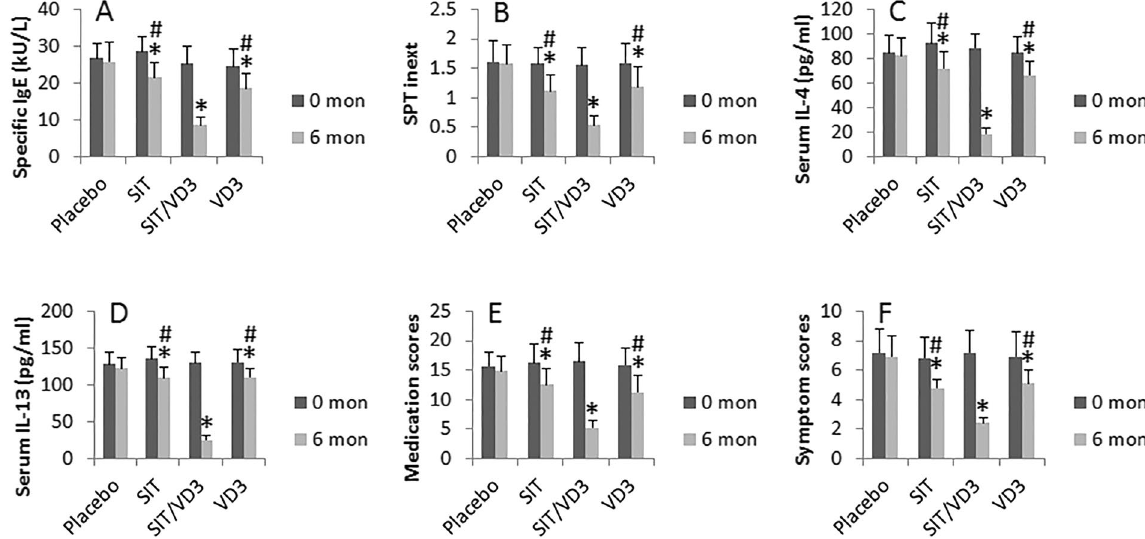
Figure 2. VD3 facilitates SIT in AR. The bar graphs show the AR-related parameters collected at 0 month (mon) and 6 months from the beginning of treatment. The treatment of AR patients (20 patients/group) is denoted on the X axis. Data of bars are presented as mean ± SD. * p < 0.05, compared with the placebo group. # p < 0.05, compared with the SIT/VD3 group.